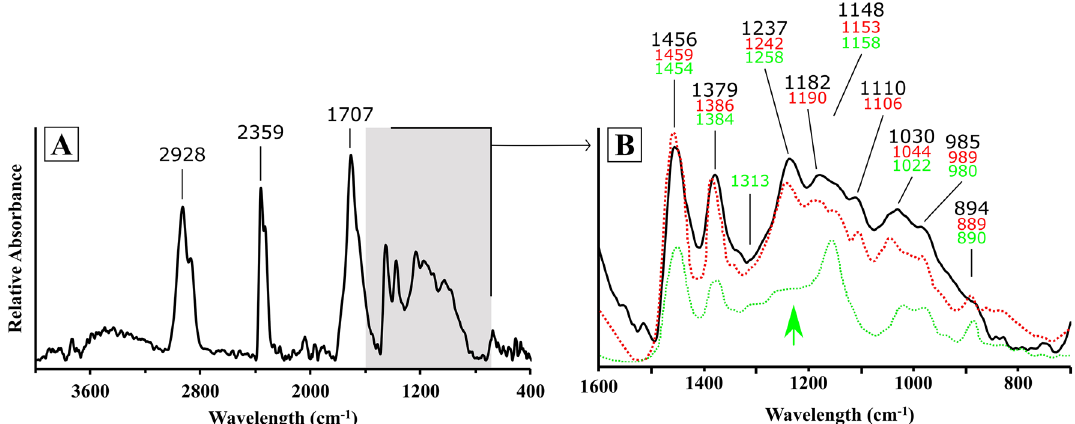
Figure 11. FTIR spectrum of the unaltered inner face of sample CH VE1405 ( A ) and detail of grey area ( B ) indicated by black line. The red dotted line shows the pattern of simetite and the green dotted line that of succinite, based on 55 . The green arrow indicates the approximate location of the ‘Baltic shoulder’.